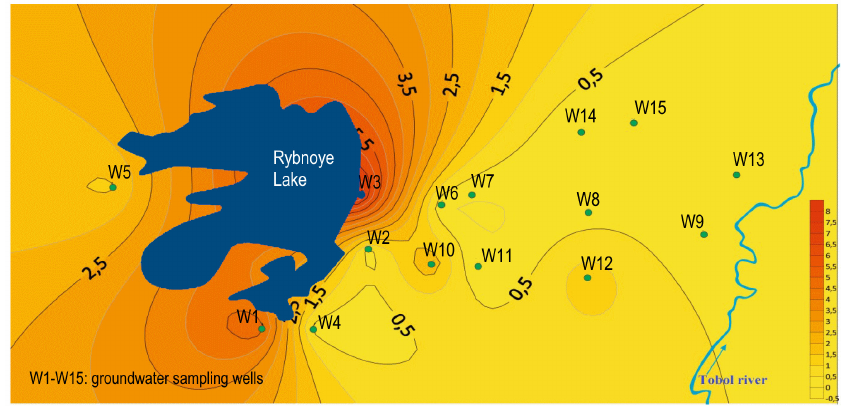
Figure 4. Isolines of ammonia nitrogen in the groundwater in the study area (mg/dm 3 ).